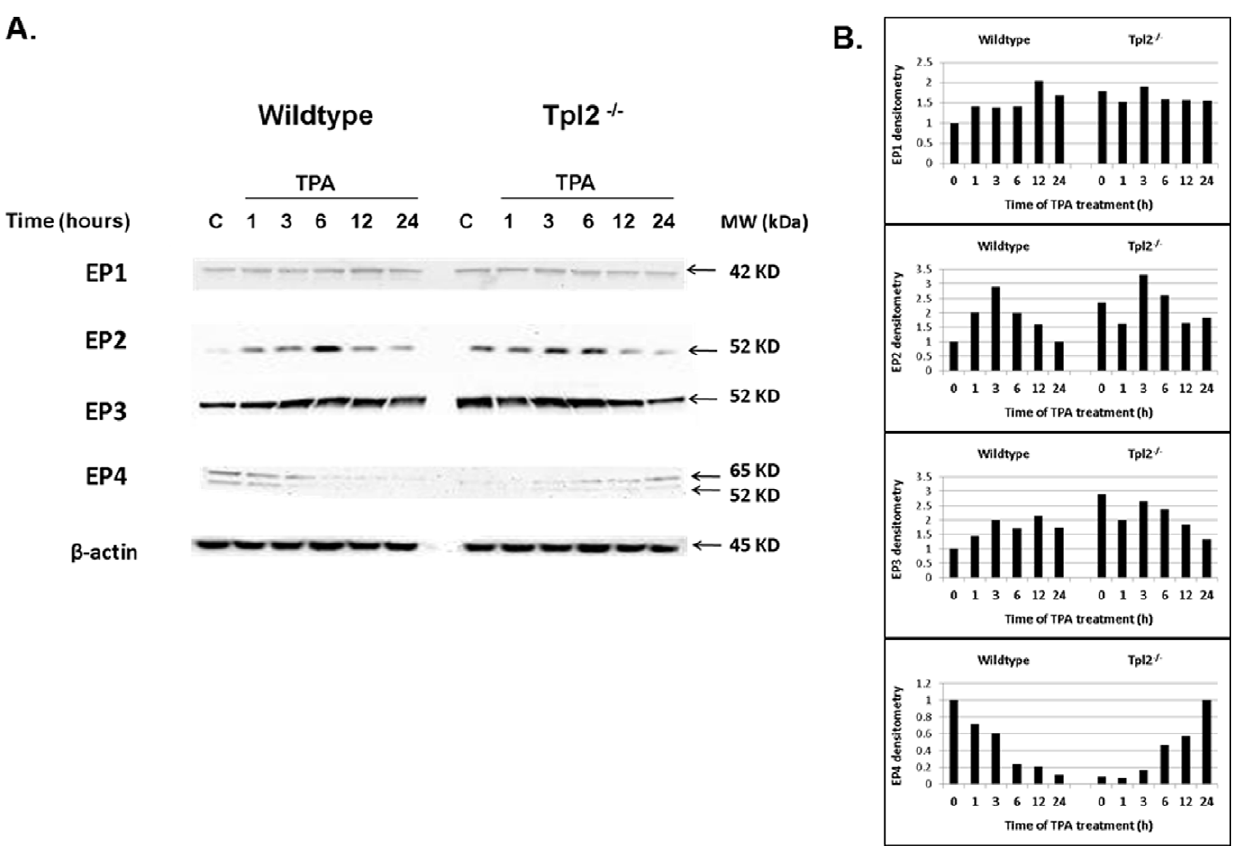
Figure 3. Western blotting of prostanoid receptor expression in wildtype and Tpl2 2 / 2 mouse keratinocytes. Wildtype or Tpl2 2 / 2 keratinocytes received DMSO only (labeled C) or TPA (10 ng/ml) for 1, 3, 6, 12, or 24 hours. Western blotting analysis was used to determine the levels of EP1, EP2, EP3, EP4, and b -actin. Bands were quantified through densitometry (Image J) and normalized to b -actin.